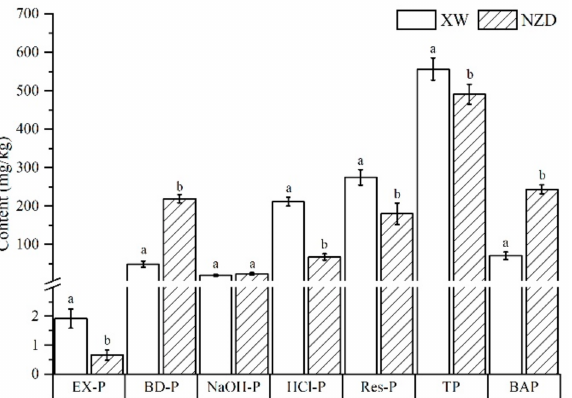
Figure 3. Contents of P fractions in the sediment cores of the XW and NZD reservoirs (different letters indicate a significant difference between the XW and NZD reservoirs with p < 0.05, the bar and the vertical lines represent the average values and standard deviations,